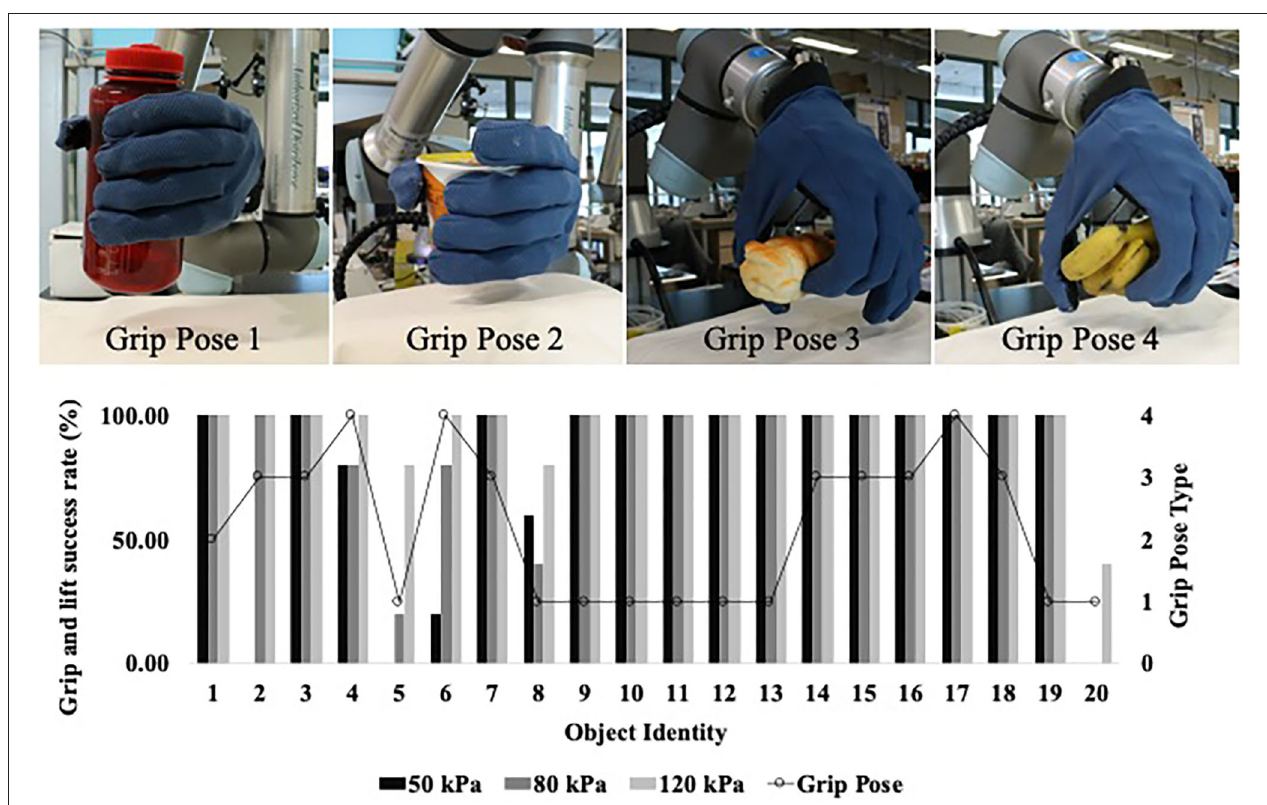
FIGURE 7 | Grasp and lift success rates of 20 objects out of five trials and the type of grasp pose that were used to pick up the